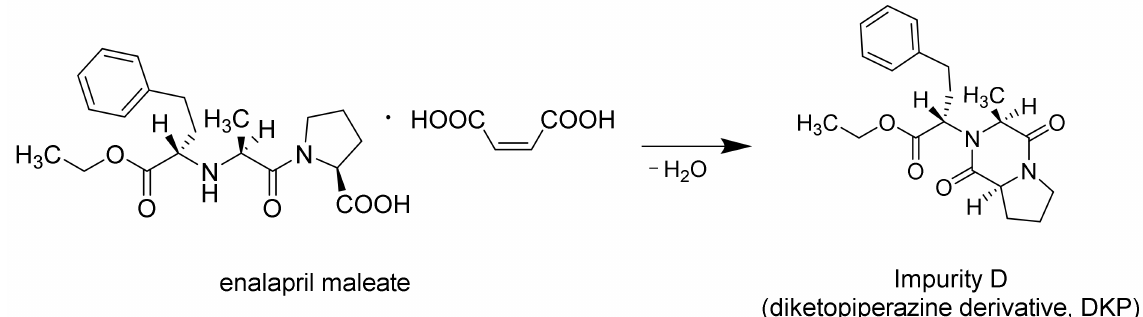
Figure 5. Illustration of the conversion of enalapril maleate to Impurity D at elevated temperatures. Content data after extrusion have been discussed in our paper [19]. For formulation F1, it was observed that the content of enalapril in the extrudates extruded at 100 ◦ C was 94.83 ± 1.72% after extrusion [19] and decreased after the FDM 3D printing process to 48.34 ± 2.69% (Figure 6). DKP was formed during both heat-intensive processes. A content of 7.54 ± 0.24% DKP was determined in the extrudates [19] and 46.84 ± 4.65% in the 3D printed tablets (Figure 6).